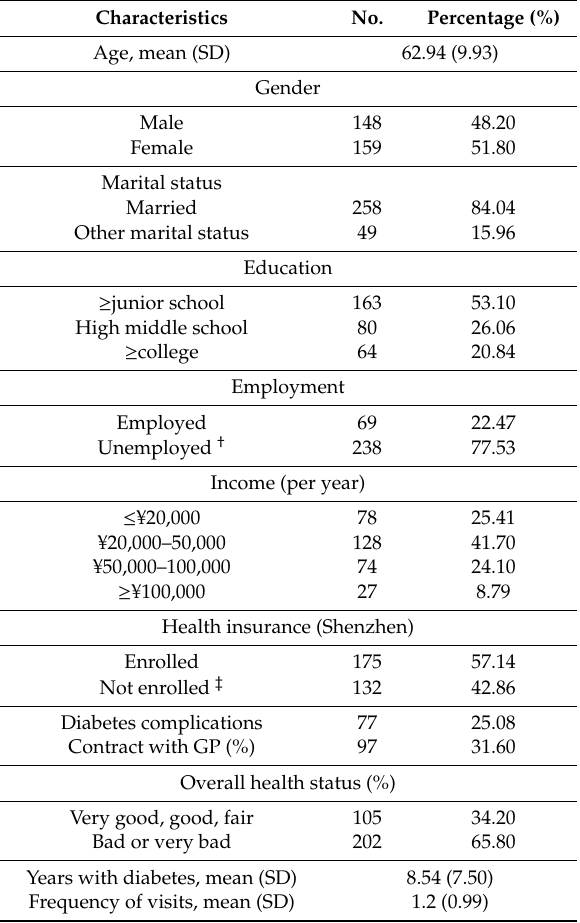
Table 2. Characteristics of the respondents ( n =